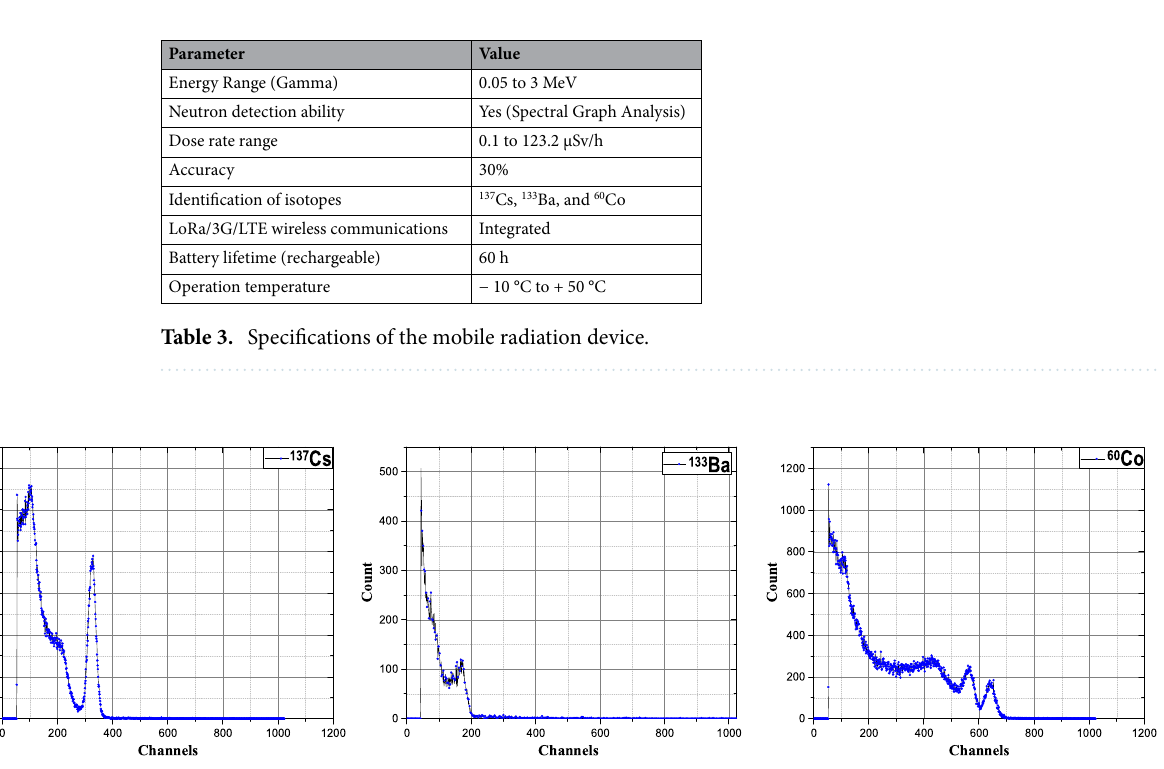
Figure 18. Spectral graph of radioactive sources detected by mobile devices (each channel corresponds to approximately 2.06